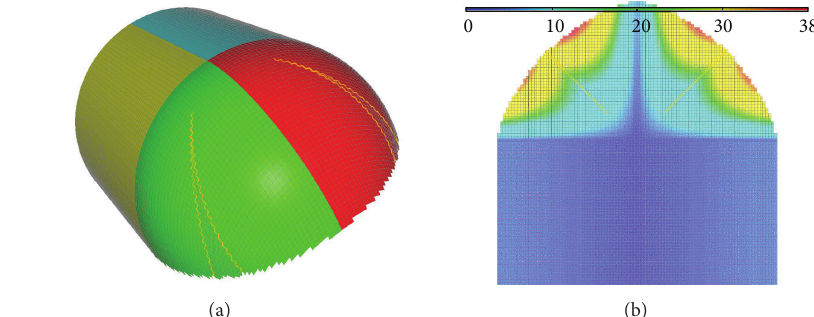
F 4: Draping of (0